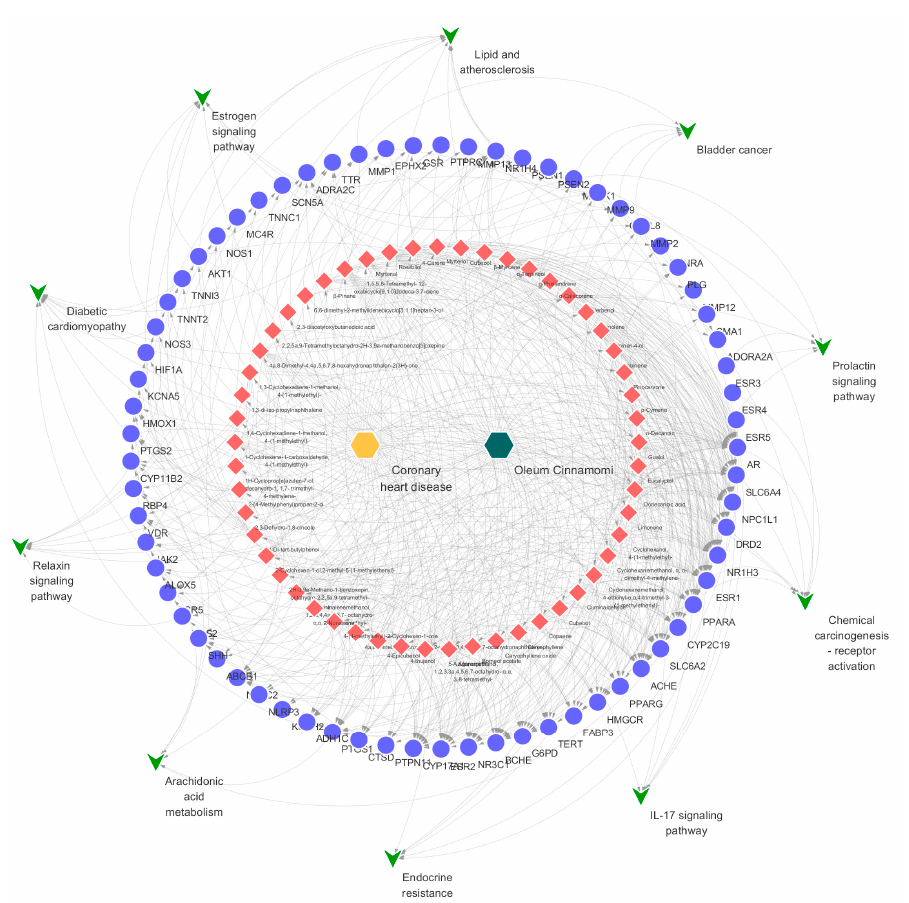
Figure 4. Chemical–target–pathway network of Oleum Cinnamomi (green arrows represent pathways; blue circles represent target genes; red diamonds represent chemicals; and orange and dark green hexagons represent drugs and diseases, respectively).